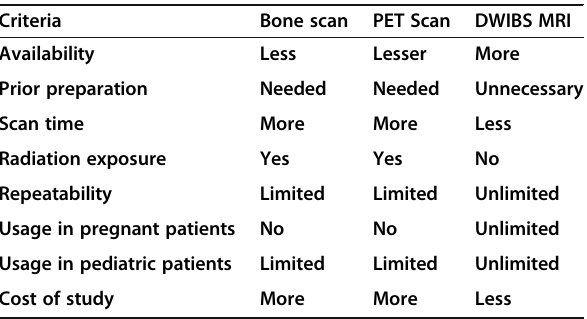
Table 8 The relative availability of DWIBS MRI on the contrary to bone scan and